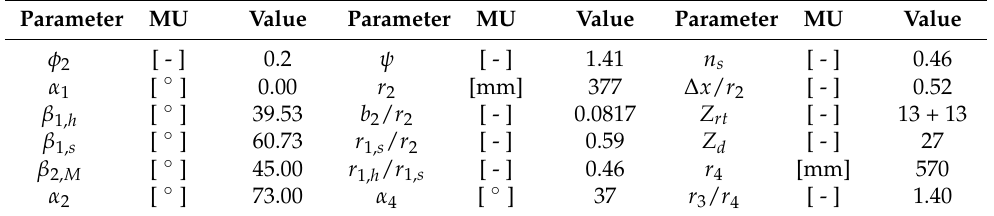
Table 4. Centrifugal compressor design output Z rt specifies the overall number of impeller main and splitter blades. Subscripts: 1—rotor inlet; 2—rotor outlet; 3—diffuser inlet; 4—diffuser